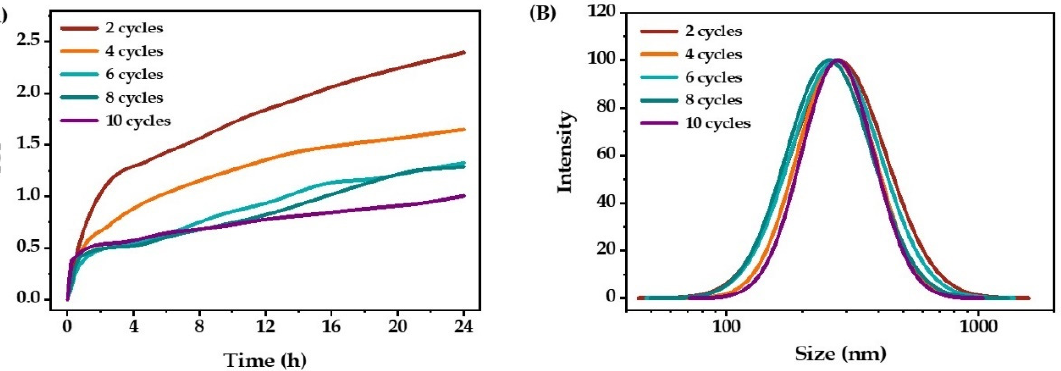
Figure 6. The stability ( A ) and droplet size distribution ( B ) of O/W emulsions prepared after different homogenization processing cycles.